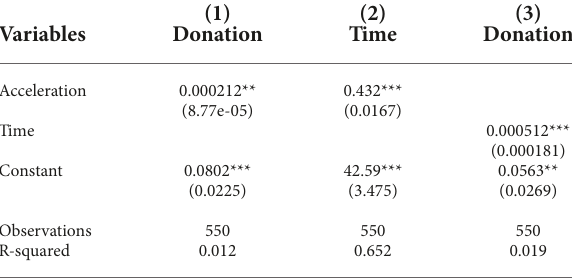
TABLE A1 A mediation estimation supports the neurologic model.